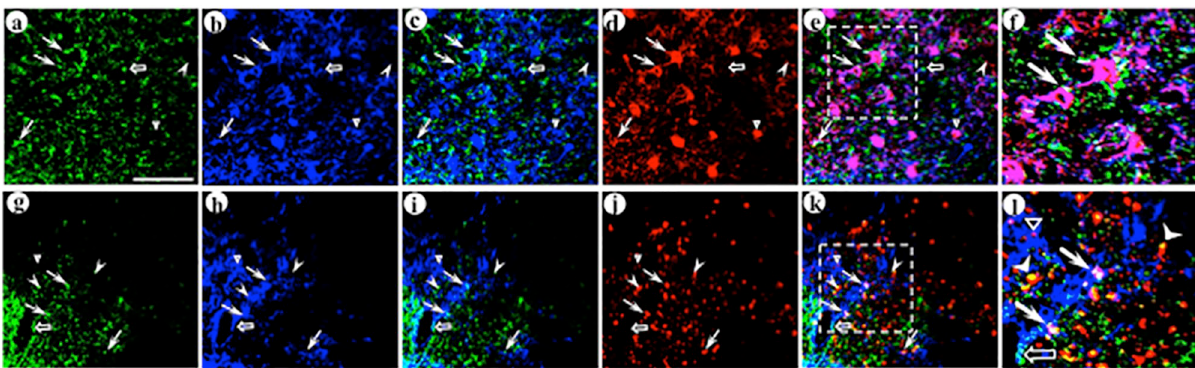
Fig 8. The synthetic peptide neurotransmitter dcv-secretogranin/anti-GABA A ß2or3-HtoL/his-tag supports gene transfer to the parvalbumin- containing subtype of GABAergic neurons. The experimental design was as above. Using immunofluorescent costaining, the upper layers of POR cortex were analyzed for expression from the presynaptic vector (His tag-IR), the targeted postsynaptic vector (GFP-IR), and the GABAergic subtype marker parvalbumin. (A-F) Image stacks show neuronal morphology for the transduced postsynaptic dendrites and cell bodies, proximal to transduced axons; (A) His tag-IR (fluorescein-conjugated secondary antibody), (B) GFP-IR (Alexa Fluor 633-conjugated secondary antibody), (C) merge of His tag-IR and GFP-IR, (D) parvalbumin-IR (TRITC-conjugated secondary antibody), (E) merge of all three IR, (F) merge, an enlarged area showing adjacent transduced axons and dendrites that contain parvalbumin-IR. Arrows, transduced axons proximal to transduced dendrites, with parvalbumin- IR. Open arrow, a transduced axon proximal to a transduced dendrite that lacks parvalbumin-IR. Arrowhead, a transduced axon distant from a transduced dendrite, but proximal to parvalbumin-IR. Open triangle, a transduced dendrite that contains parvalbumin-IR, but distant from a transduced axon. (G-L) Single confocal images in each channel show that delivery of this presynaptic vector, followed by the targeted postsynaptic vector, supported gene transfer across GABA A ß2- or ß3-containing synapses to parvalbumin-containing postsynaptic neurons; (G) His tag-IR, (H) GFP-IR, (I) merge of His tag-IR and GFP-IR, (J) parvalbumin-IR, (K) merge of all three IR, (L) merge, an enlarged area showing adjacent transduced axons and dendrites that contain parvalbumin-IR. Panels G-L show a different field than for panels A-F. Scale bar: 20 μ m.